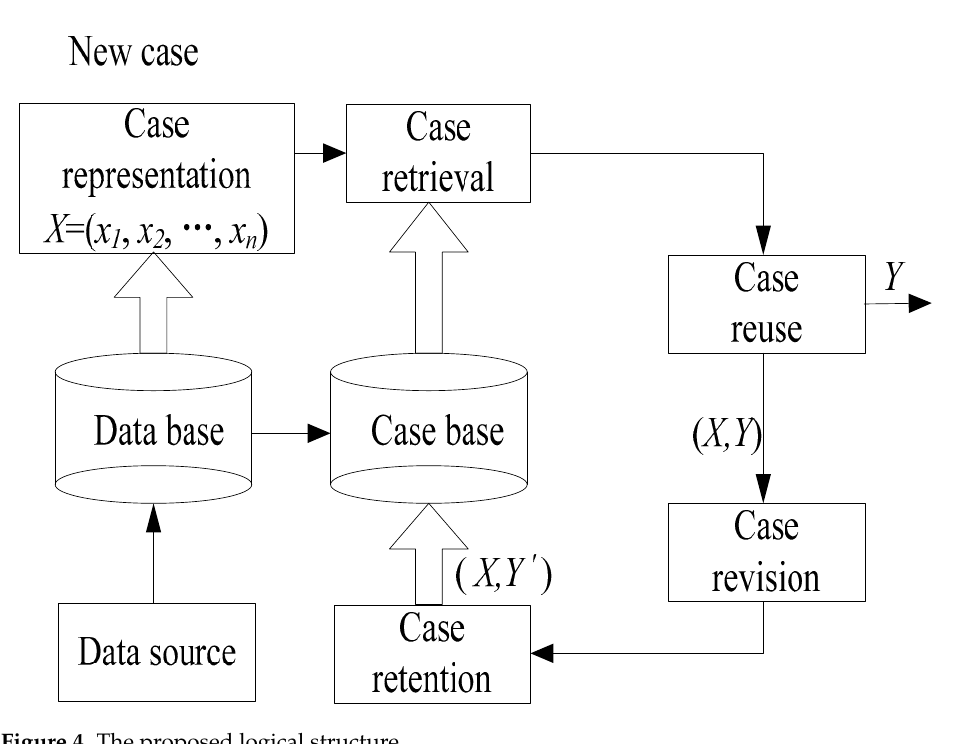
Appl. Sci. 2021 , 11 , x FOR PROOFREADING Figure 4. The proposed logical structure. Figure 4. The proposed logical structure.